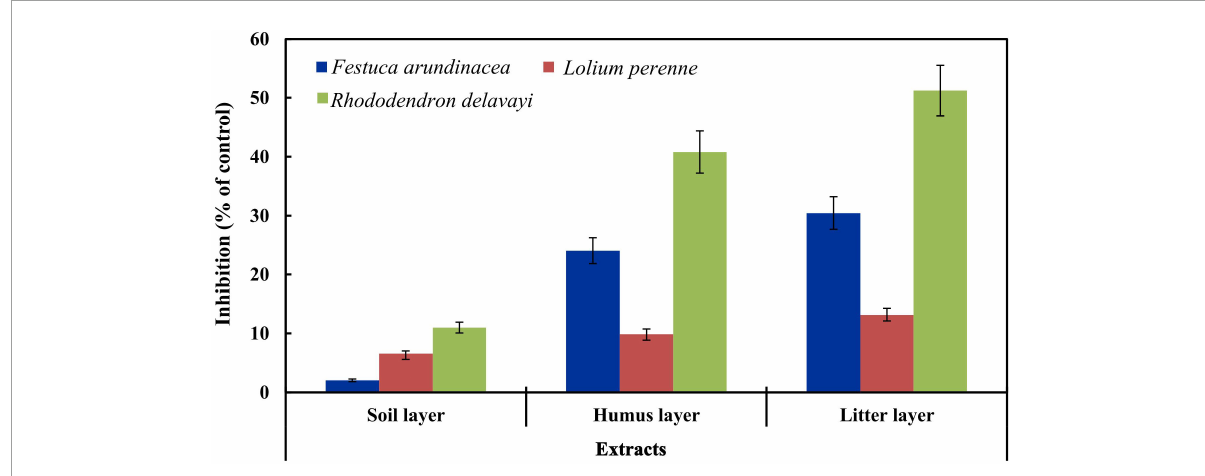
FIGURE2 Inhibitory effects of extracts on seed germination. Vertical bars represent the standard deviations ( n =